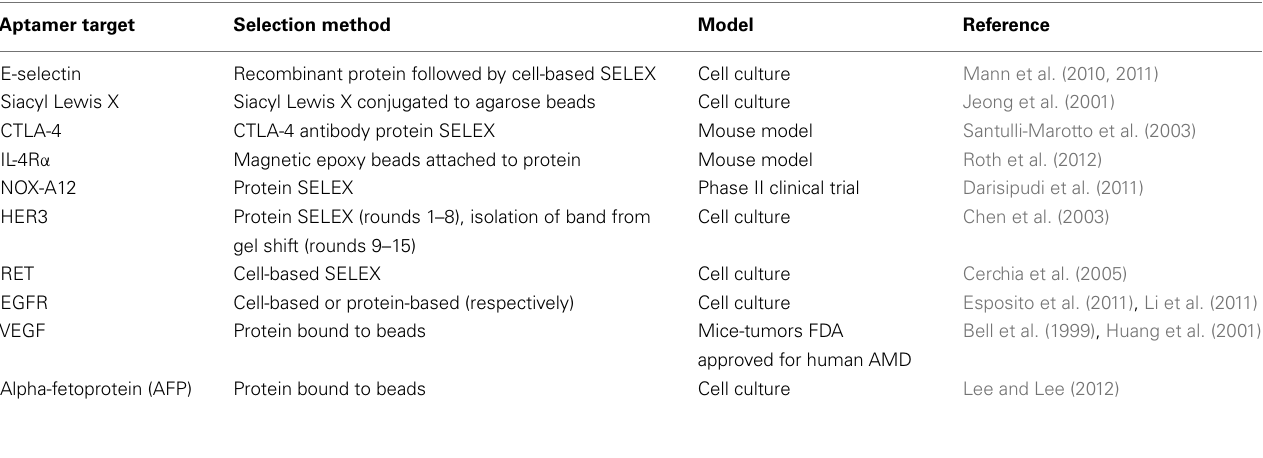
Table 1 |Therapeutic RNA aptamers for treatment of